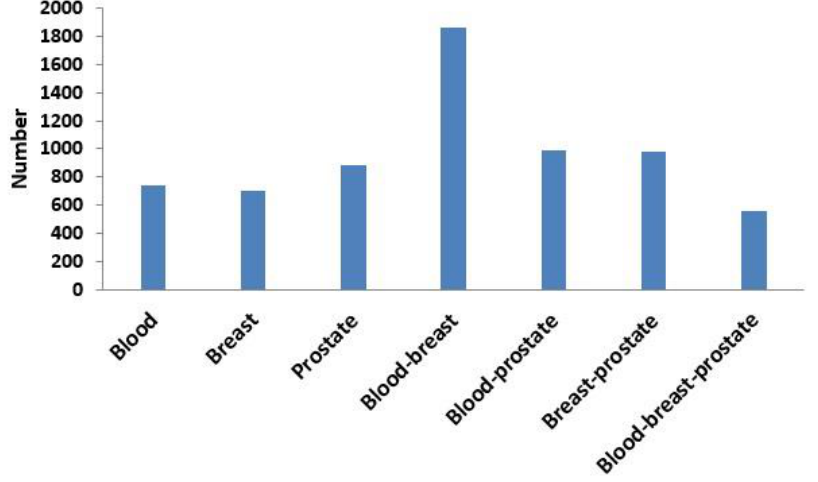
Figure 6. Numbers of overlapping modules between the single-layer network (blood, breast, or prostate) and three-layer network and between two or three single-layer networks. Int. J. Mol. Sci. 2020 , 21 , x FOR PEER REVIEW